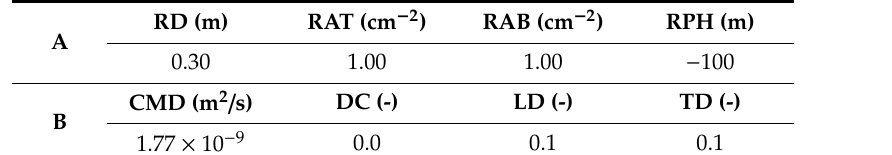
Table 2. (A) Values of the time-varying parameters controlling water losses by evapotranspiration used for numerical modeling: RD = rooting depth; RAT = root activity at top; RAB = root activity at base; RPH = root pressure head. (B) Hydrodynamic parameters for nitrates: CMD = coefficient of molecular diffusion from [73]; DC = constant for first-order decay; LD and TD = longitudinal and transverse dispersivity, respectively.